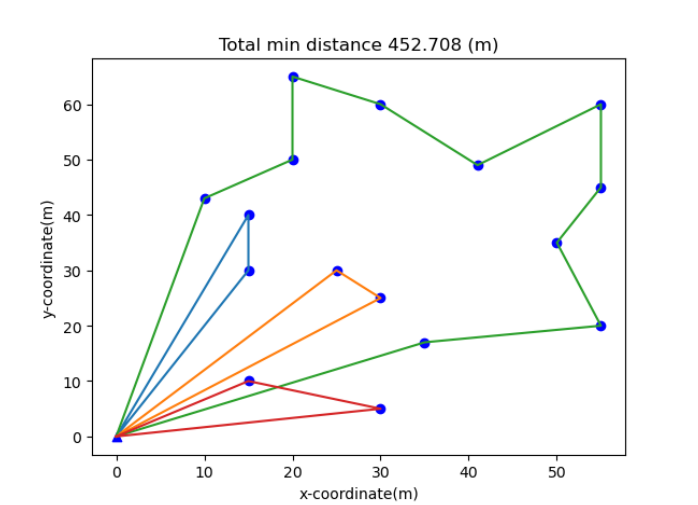
Figure 15. Schematic of sub route